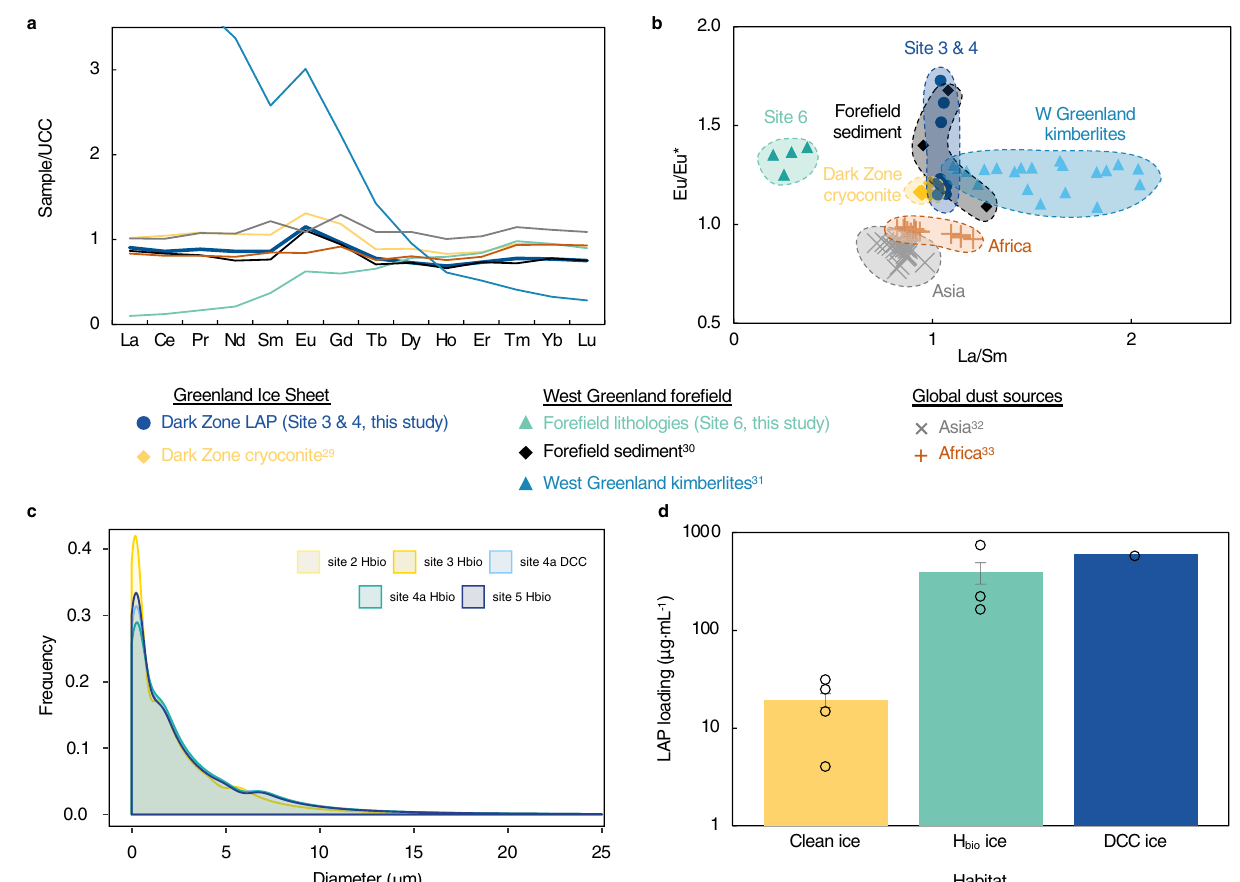
Fig. 6 Rare Earth element signature and grain size distribution for mineral dust in Dark Zone particulates. a , b Rare Earth element (REE) normalized to the upper continental crust (UCC) compared to potential sources; c mineral dust size distribution; and d particulate mass loading by habitat. In d plot shows mean ± SE, clean ice: n = 4 samples, high algal biomass ice (H bio ) ice: n = 3 samples, dispersed cryoconite (DCC) ice: n = 1 (Fig. 3e, Supplementary Table 5). In spite of its dominance by mass, mineral dust is not the primary cause of ice surface dar- kening in the GrIS Dark Zone. In situ spectral re fl ectance mea- surements at Site 4 combined with refractive index and mineral dust grain-size distribution measurements in a radiative transfer model indicate that mineral dust has a negligible effect on albedo reduction compared to pigmented glacier algae 16 . Rather, our fi ndings indicate that the presence of P min may have a second- order effect on albedo. If this is the case, it follows that the spatial extent and melt rate of P-bearing ice may in part constrain the spatial distribution of the algal blooms producing the darkening observed on the landscape-scale.